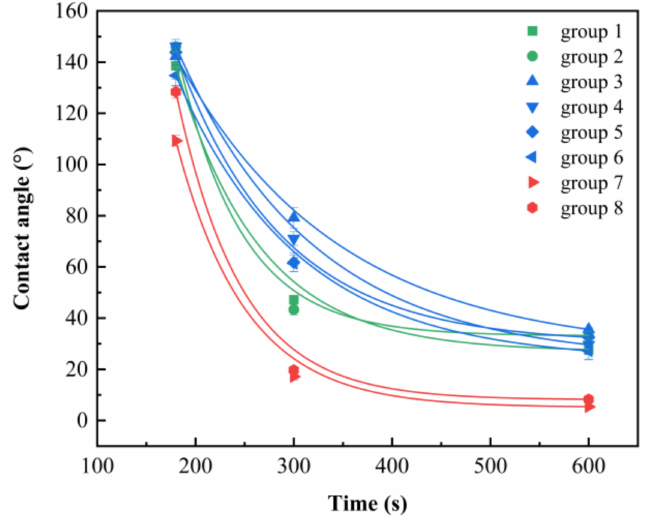
Figure 5. Variation curves of molten CMAS contact angle with time.